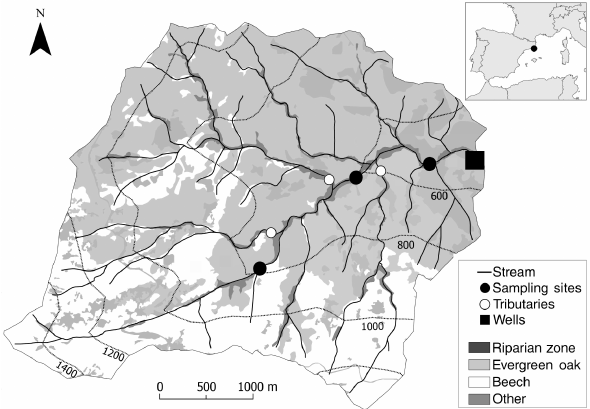
Figure 1. Map of the Font del Regàs catchment (Montseny Nat- ural Park, northeastern Spain). The location of the three sampling sites (black circles), tributaries (white circles), and the riparian plot where tree transpiration and groundwater level were measured (black square) are shown. The headwater reach is comprised be- tween the up- and midstream sampling sites, while the valley reach is comprised between the mid- and downstream sampling